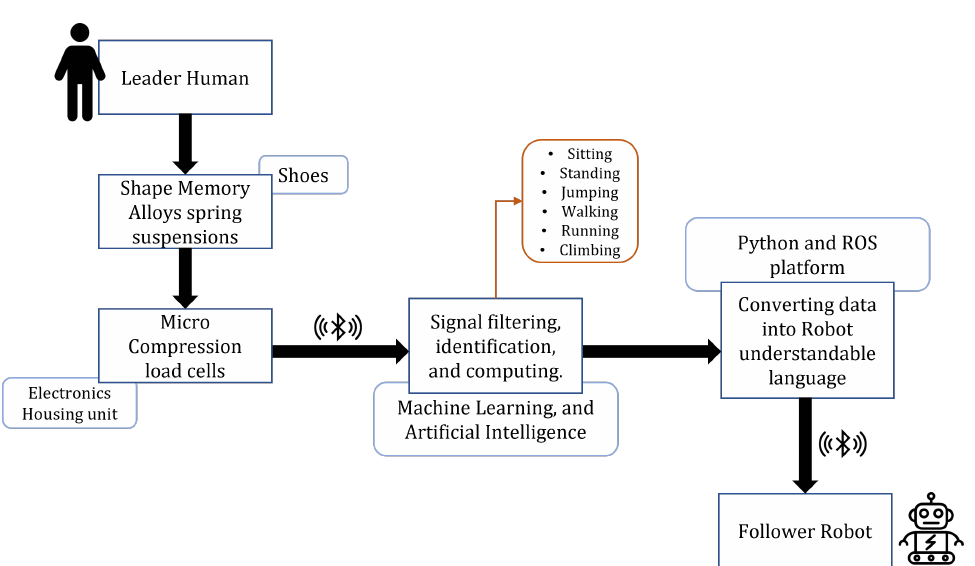
Figure 9. Algorithm for the HRI use case framework. The Machine Learning algorithm is essential to identify user movement conditions in real-time, especially for signal filtering and data